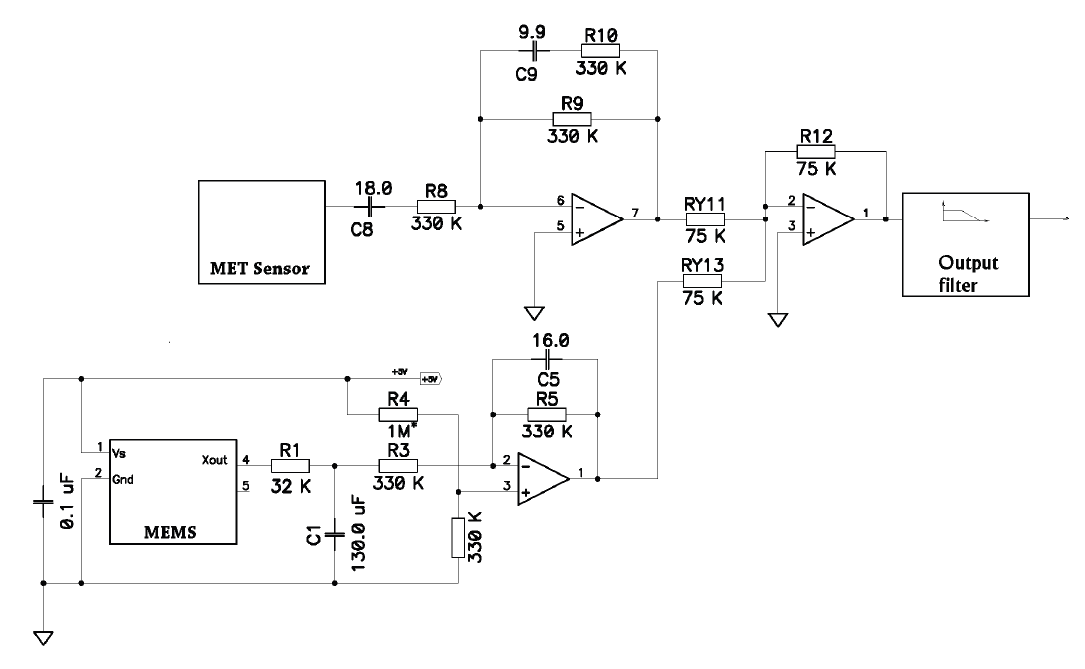
Figure 7. Schematic diagram for the combined